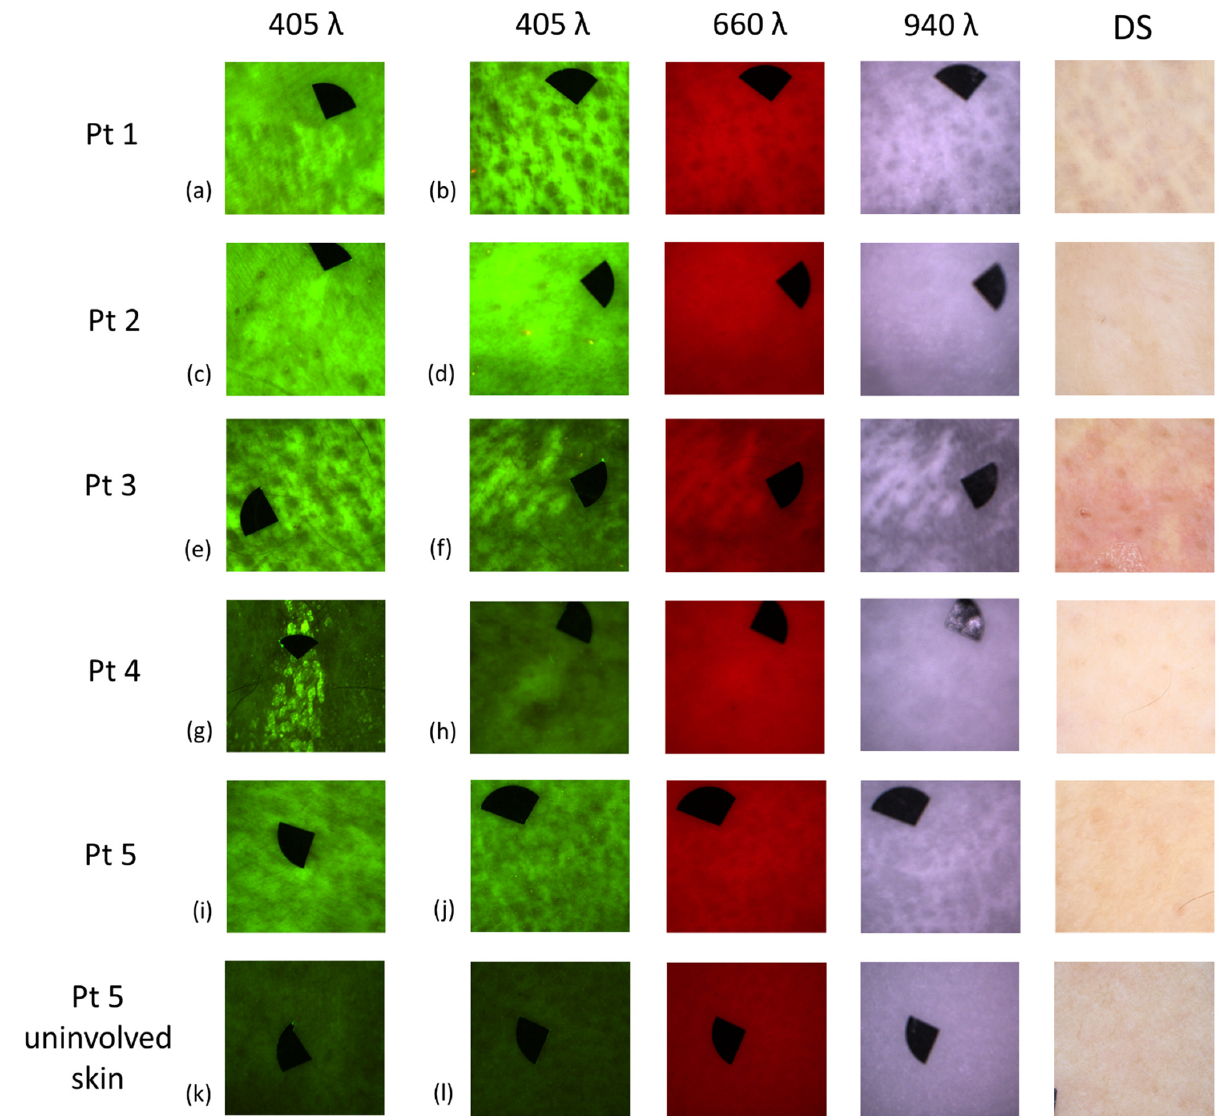
Figure 4. Representative autofluorescence (AF), diffuse reflectance (DR) and dermoscopy (DS) images of the affected skin sites of the pseudoxanthoma elasticum patients. ( a ) AF image of the axilla of Patient (Pt) 1. ( b ) AF, DR and DS images of the antecubital fossa of Pt 1, showing PXE-specific morphologic structures. ( c ) AF image of the axilla of Pt 2. ( d ) AF, DR and DS images of the inguinal region of Pt 2. AF image reveals a well-visible extensive area with high AF signal. DR images show barely noticeable pattern. DS image shows no typical pattern. ( e ) AF image of the antecubital fossa of Pt 3. ( f ) AF, DR and DS images of the neck of Pt 3, showing PXE-specific morphologic structures. ( g ) AF image from popliteal fossa of Pt 4. ( h ) AF, DR and DS images from wrist of Pt 4. AF image gives high-contrast signal. DR images are less informative. ( i ) AF image of the inguinal region of Pt 5. ( j ) AF, DR and DS images of the axilla of Pt 5, displaying PXE-specific morphologic structures. ( k ) AF images of Pt 5, uninvolved normal skin. ( l ) AF, DR and DS images of uninvolved normal skin, upper arm of Pt 5. The size of the images is 2 × 2 cm 2 . Black markers do not point to areas of interest, they are used for image alignment (area: 0.125 cm 2 ).